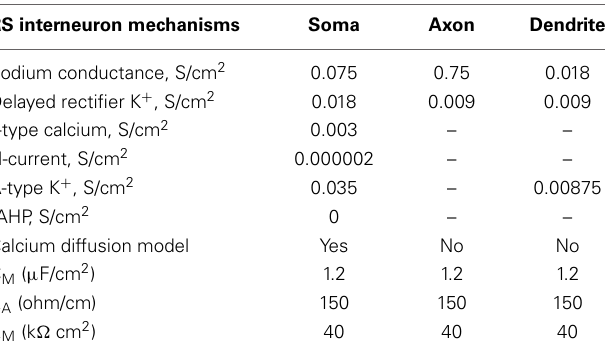
Table 3 | Active and passive ionic properties of RS interneuron model.